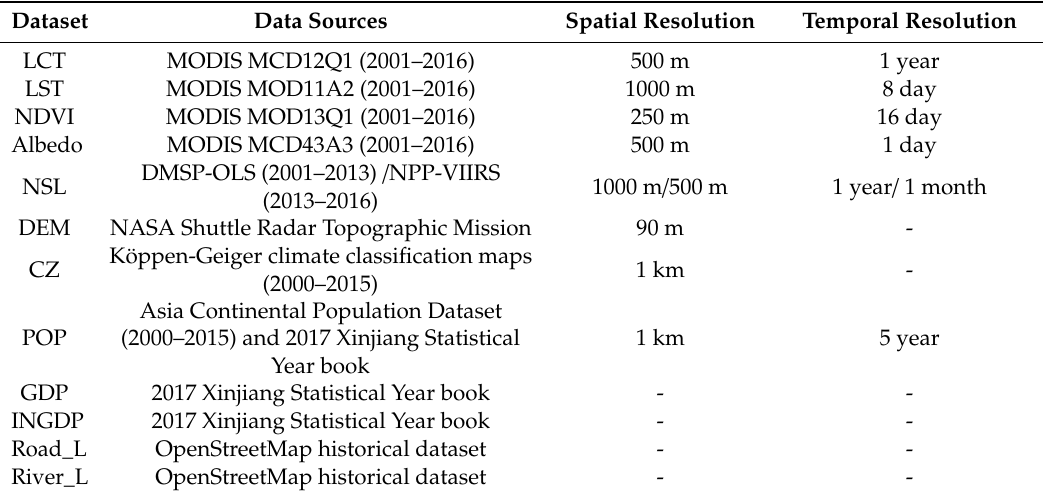
Table 1. Summary information on the used